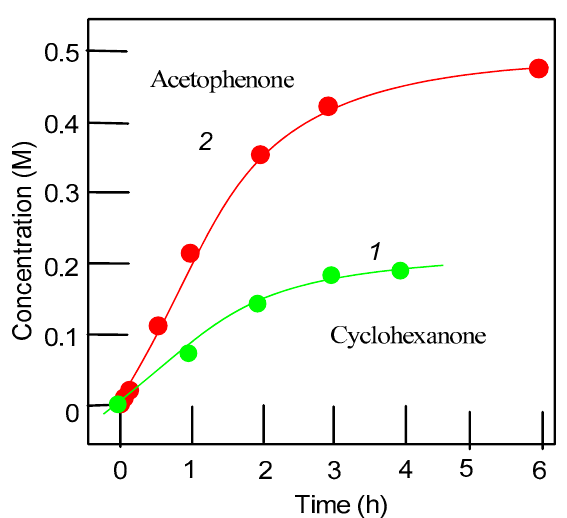
Figure 11. Accumulation of cyclohexanone (curve 1 ), and acetophenone (curve 2 ) in the oxidation of cyclohexanol (0.5 M) or 1-phenylethanol (0.5 M), respectively, with tert -butyl hydroperoxide (1.5 M) catalyzed by complex 2 (5 × 10 − 4 M) at 50 °C in acetonitrile. In order to quench the oxidation process concentrations of products were measured by GC only after the reduction of the reaction sample with solid PPh 3 .